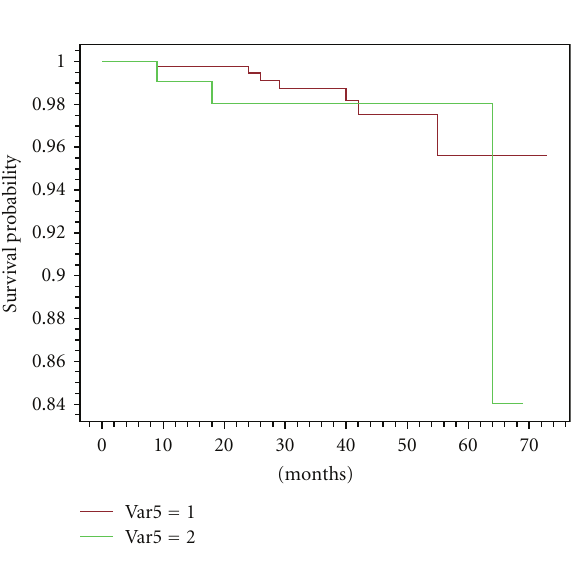
Figure 3: Curves of disease-free survival distant metastases. Var5 1: patients with unmodified surgery after CE-MRM Var5 2: patients with modified surgery after CE-MRM P = . 002.